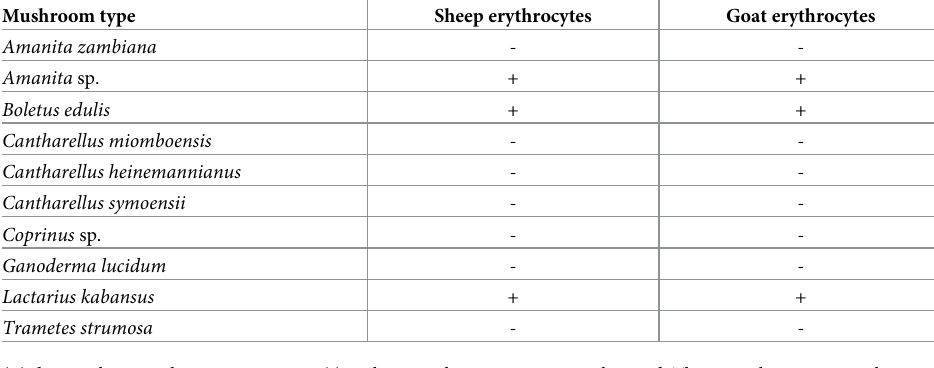
Table 1. Haemagglutination assay of the ten mushroom species with sheep and goat erythrocytes. Mushroom